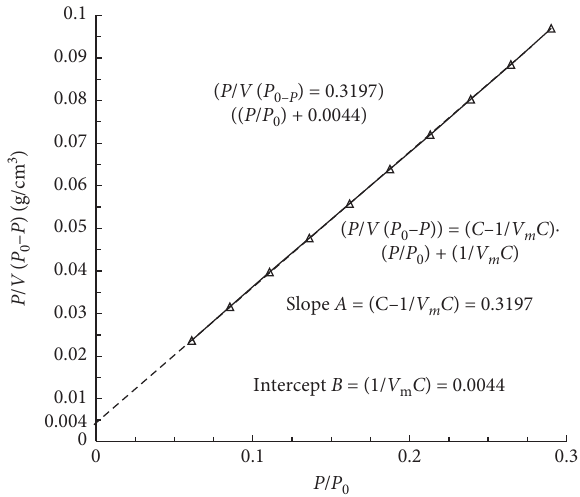
Figure 7: The BET figure of NCG